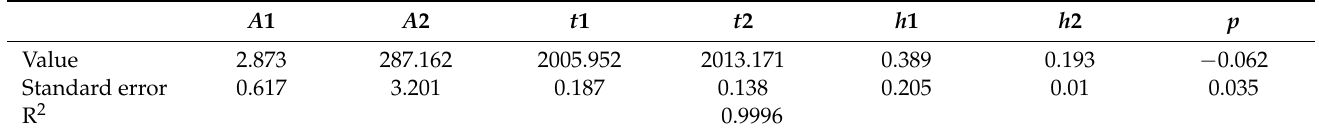
Table 3. BiDoseResp model parameters for technological trend of microalgae lipids.